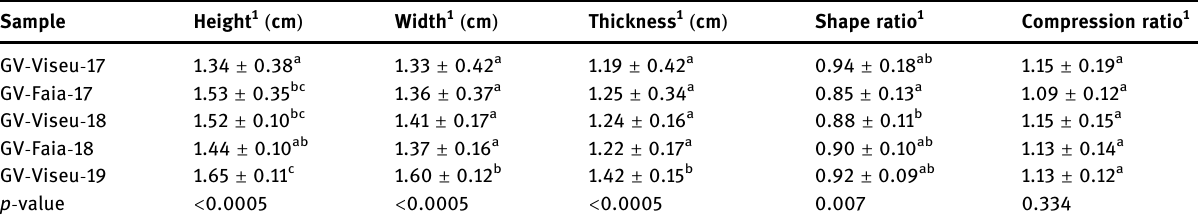
Table 3: Biometric measures of the kernels ( mean ± standard deviation )